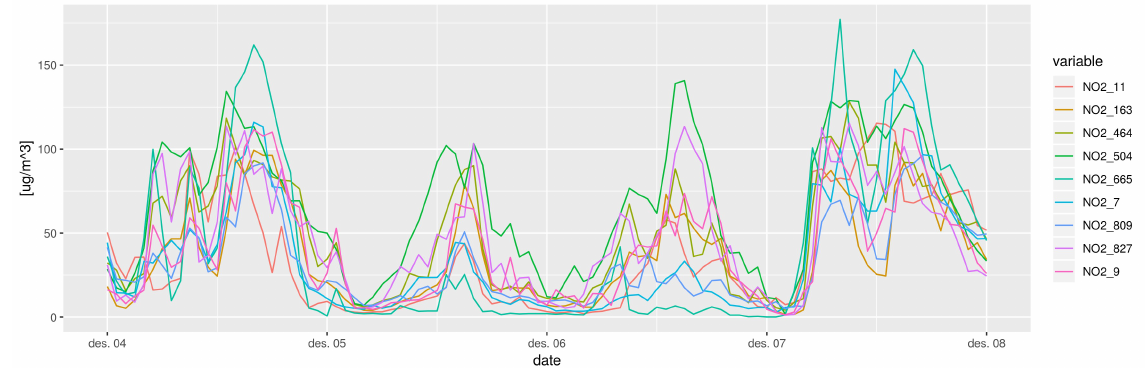
Figure 3. NO 2 observation timeseries between 4 December 2015 00:00:00 and 8 December 2015 00:00:00 of the nine monitoring stations in the municipality of